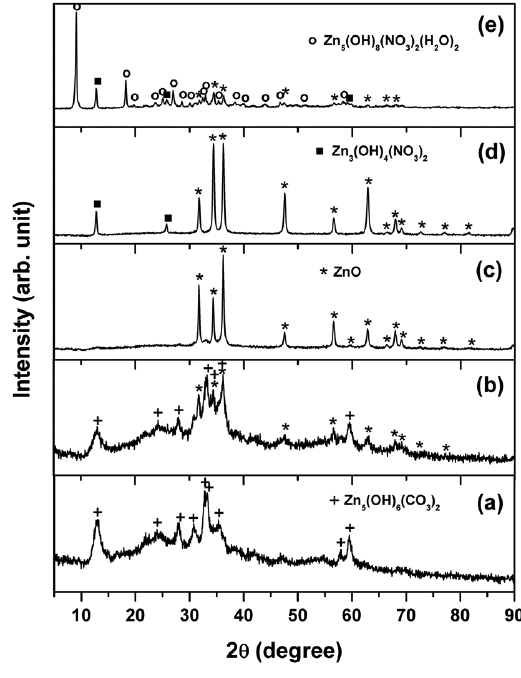
Figure 1. XRD patterns of samples: (a) F1, (b) F2, (c) F3, (d) F4 and (e)